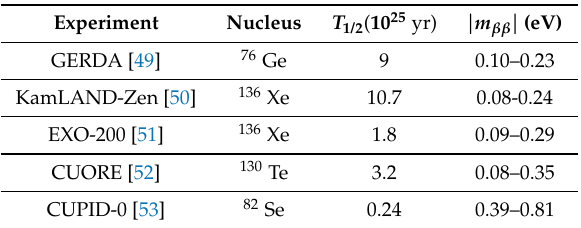
Table 2. Lower limits of half-lives and upper limits for the effective Majorana mass, obtained in recent experiments on the search for the 0 νββ